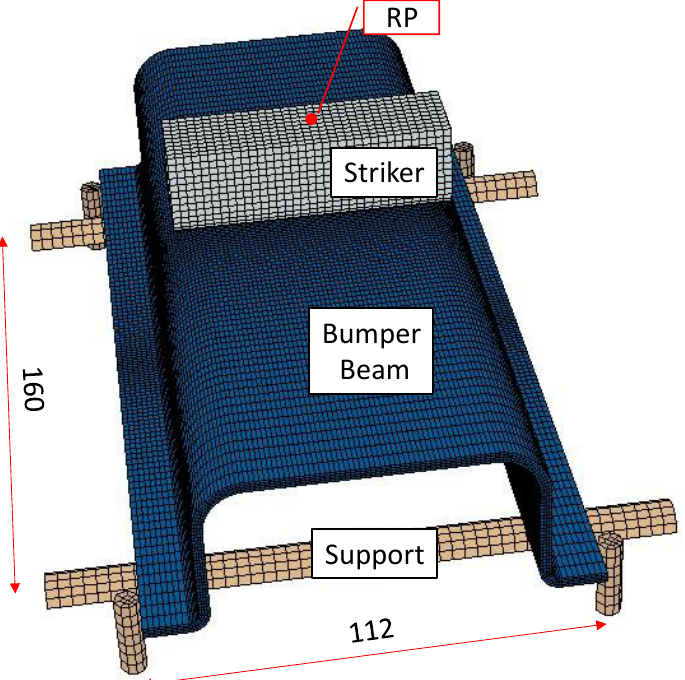
Figure 3. Numerical model of the bumper beam under low-velocity impact test. The overall setting and dimension.